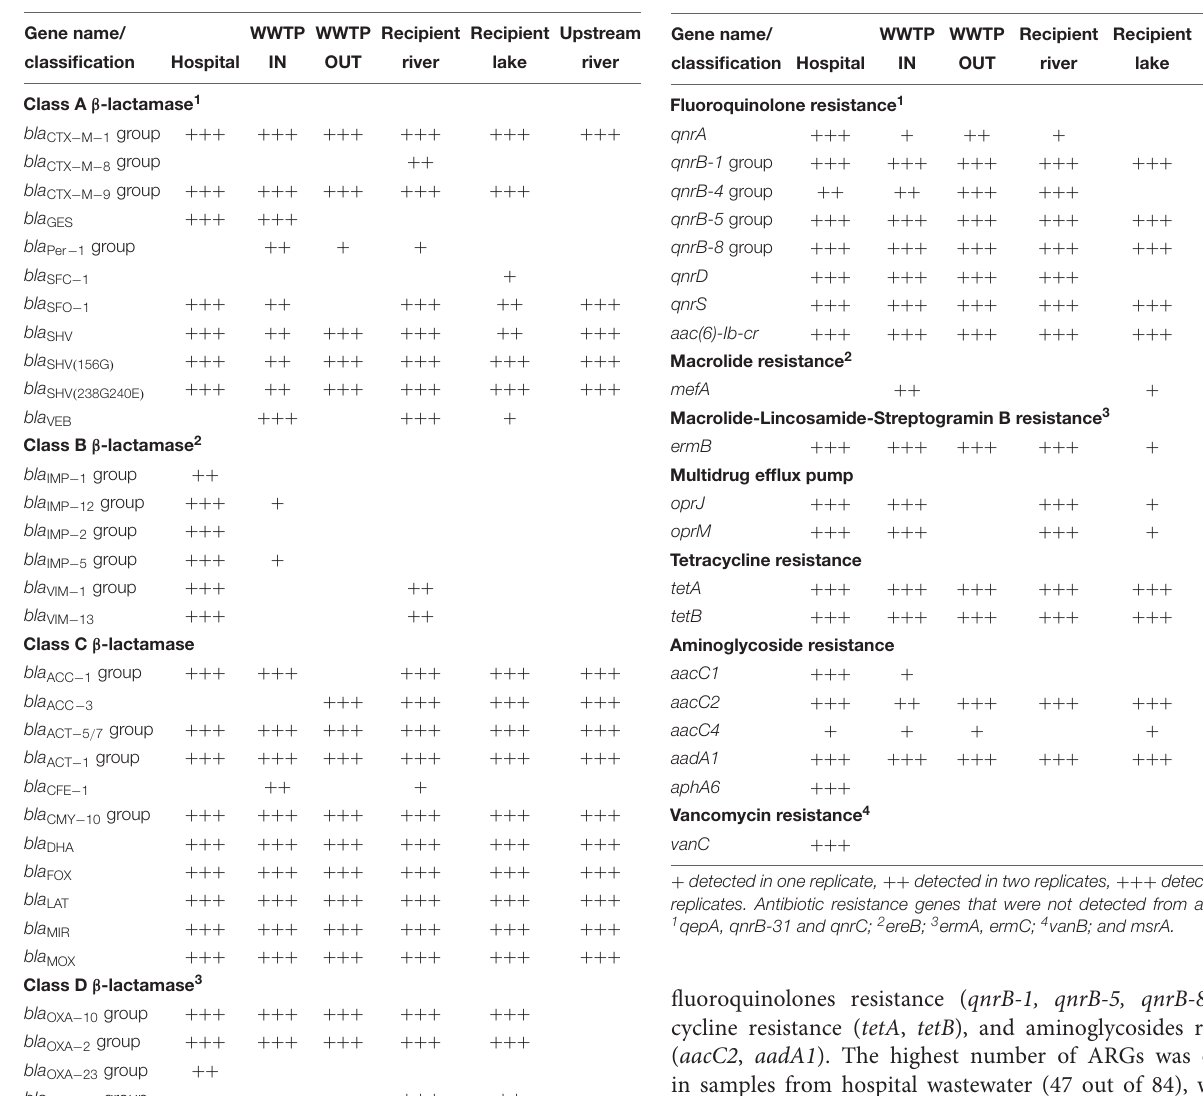
TABLE 3 | Antibiotic resistance genes (other than β -lactamase genes) identified in samples from hospital wastewater, WWTP, river and lake water in